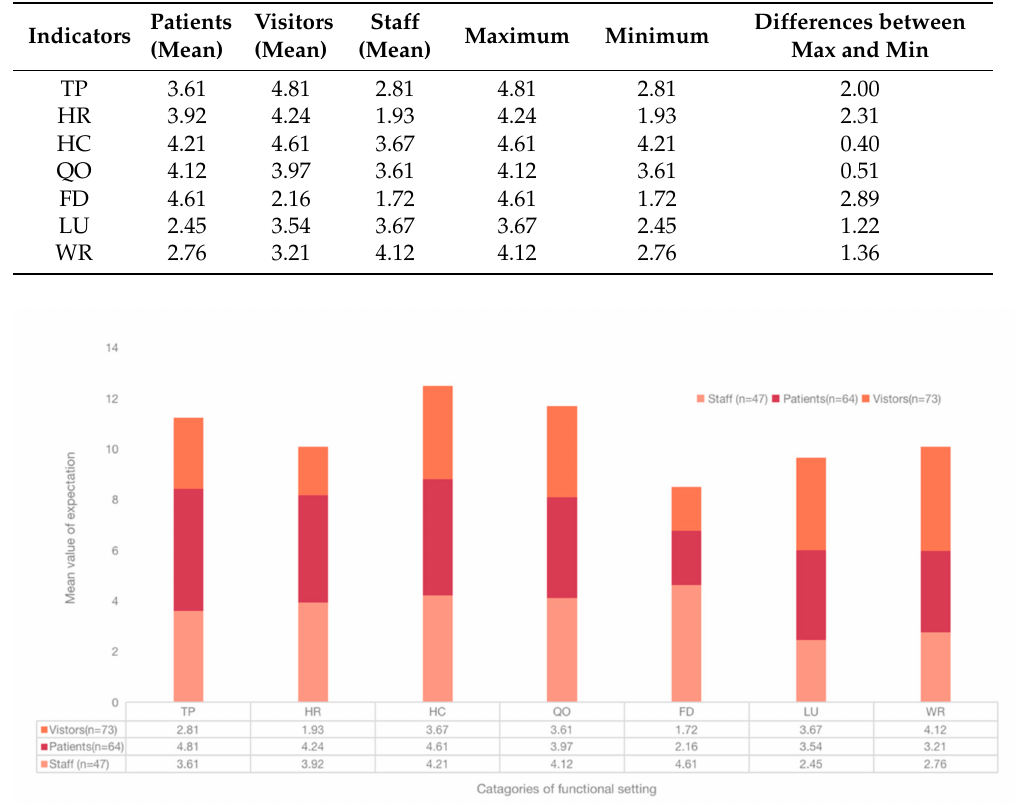
Figure 5. Expectation on the functional